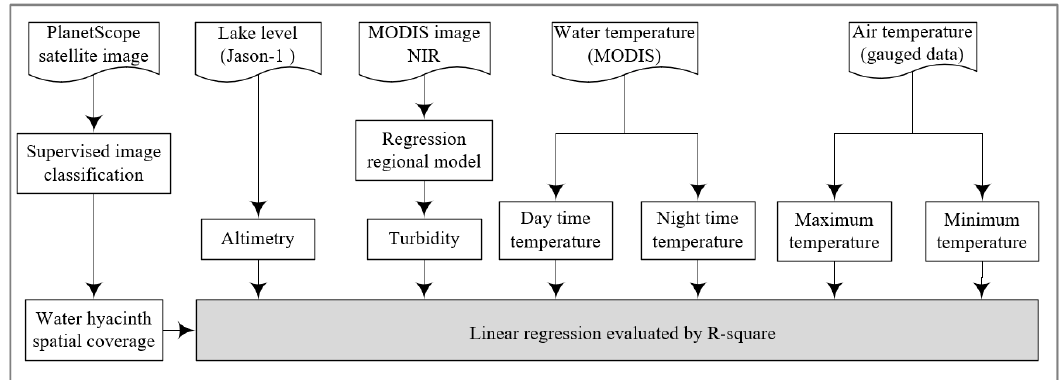
Figure 3. The framework developed to map the water hyacinth spatiotemporal distribution and determine the environmental factors attributing to the water hyacinth spatial coverage dynamics.